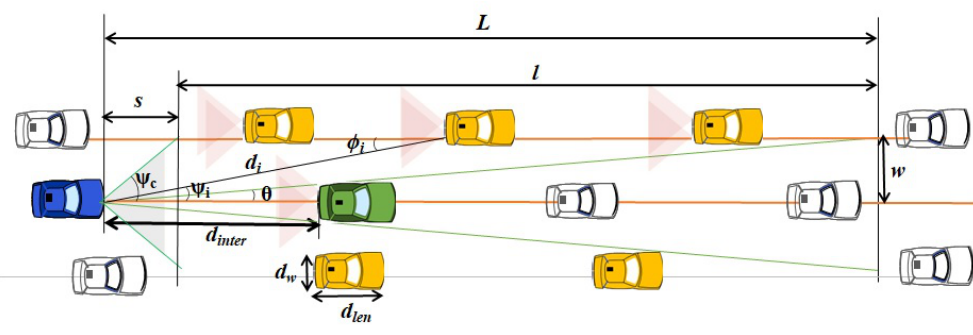
Figure 3. Target